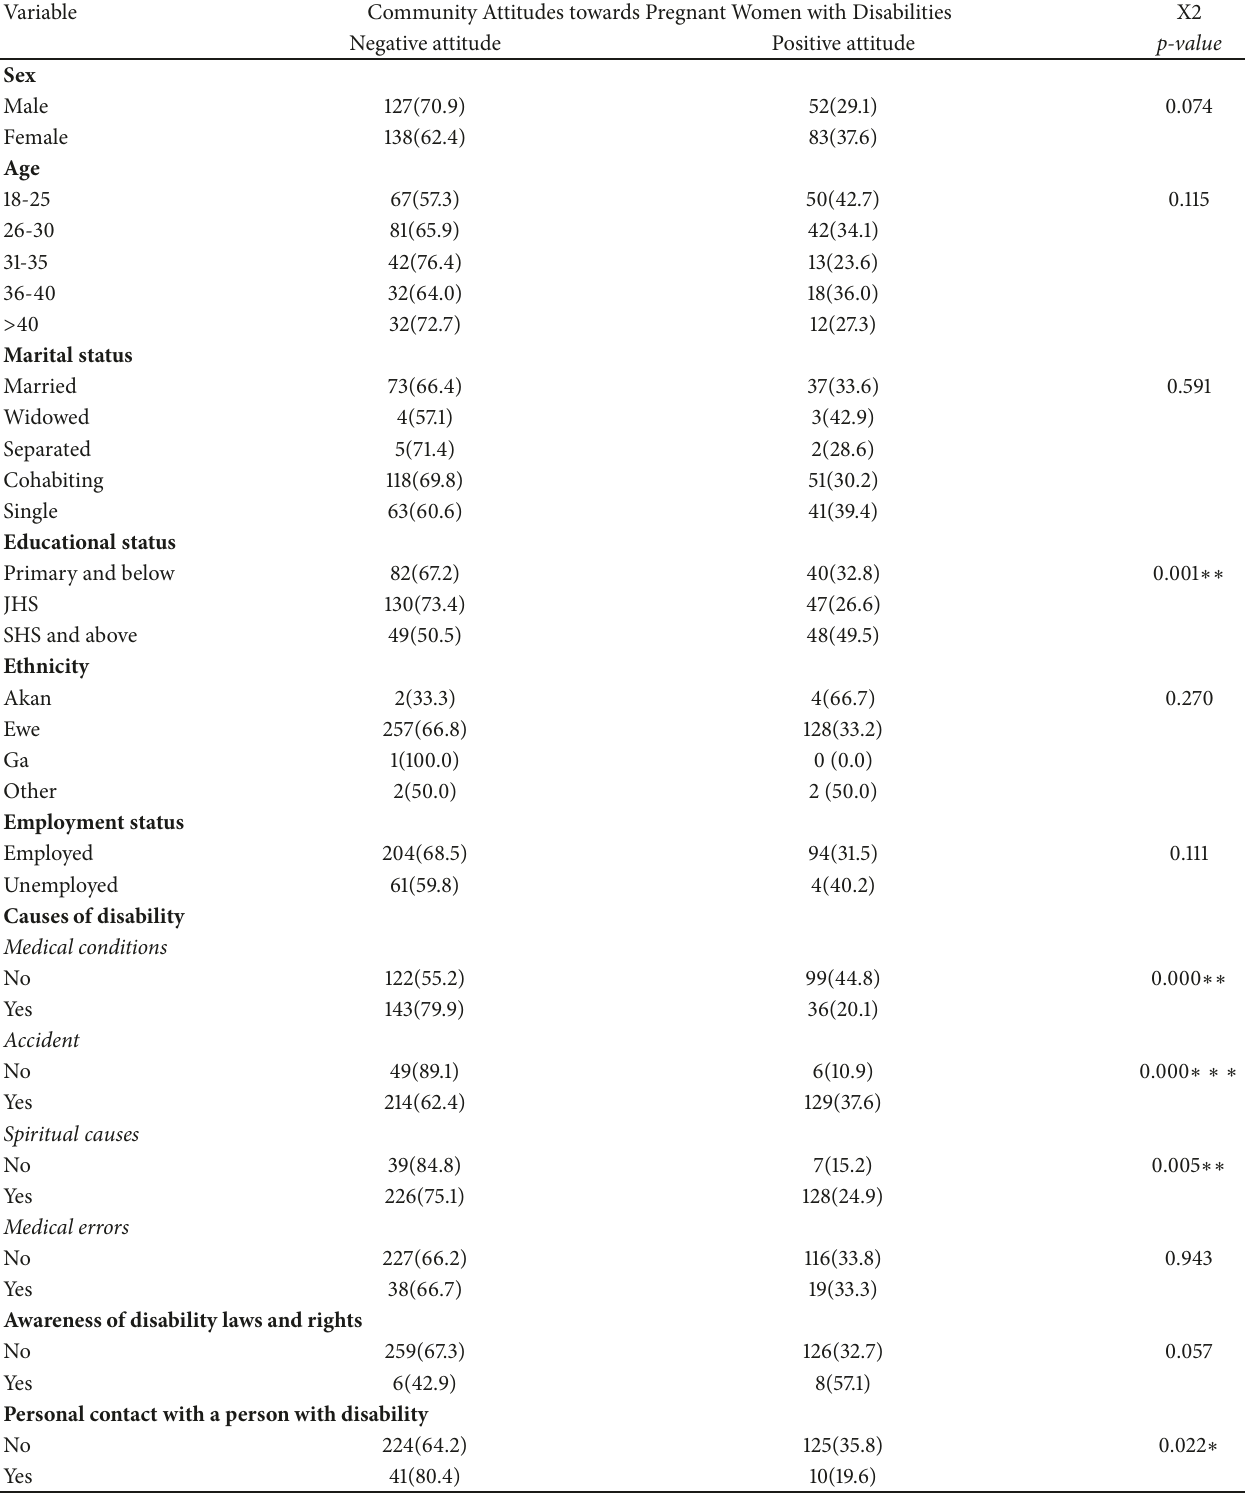
Table 5: Factors influencing attitudes towards pregnancy in